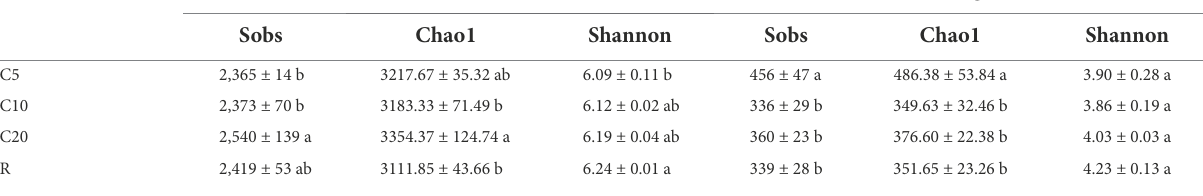
TABLE 3 Diversity indexes of soil bacterial and fungal communities.